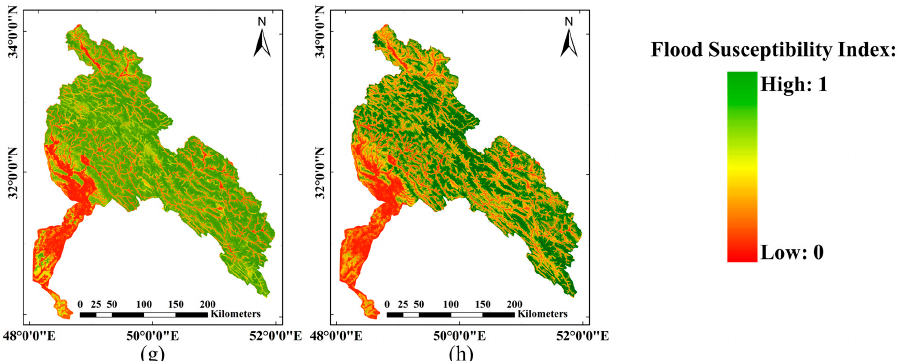
Figure 8. Comparison of the FSM for the Karun basin: ( a ) Support Vector Machine (SVM), ( b ) Random Forest (RF), ( c ) Deep Neural Network (DNN), ( d ) Decision Tree (DT), ( e ) Light Gradient Boosting Machine (LightGBM), ( f ) Categorical Boosting (CatBoost), ( g ) Extreme Gradient Boosting (XGBoost), and ( h ) Cascade Forest Model (CFM).